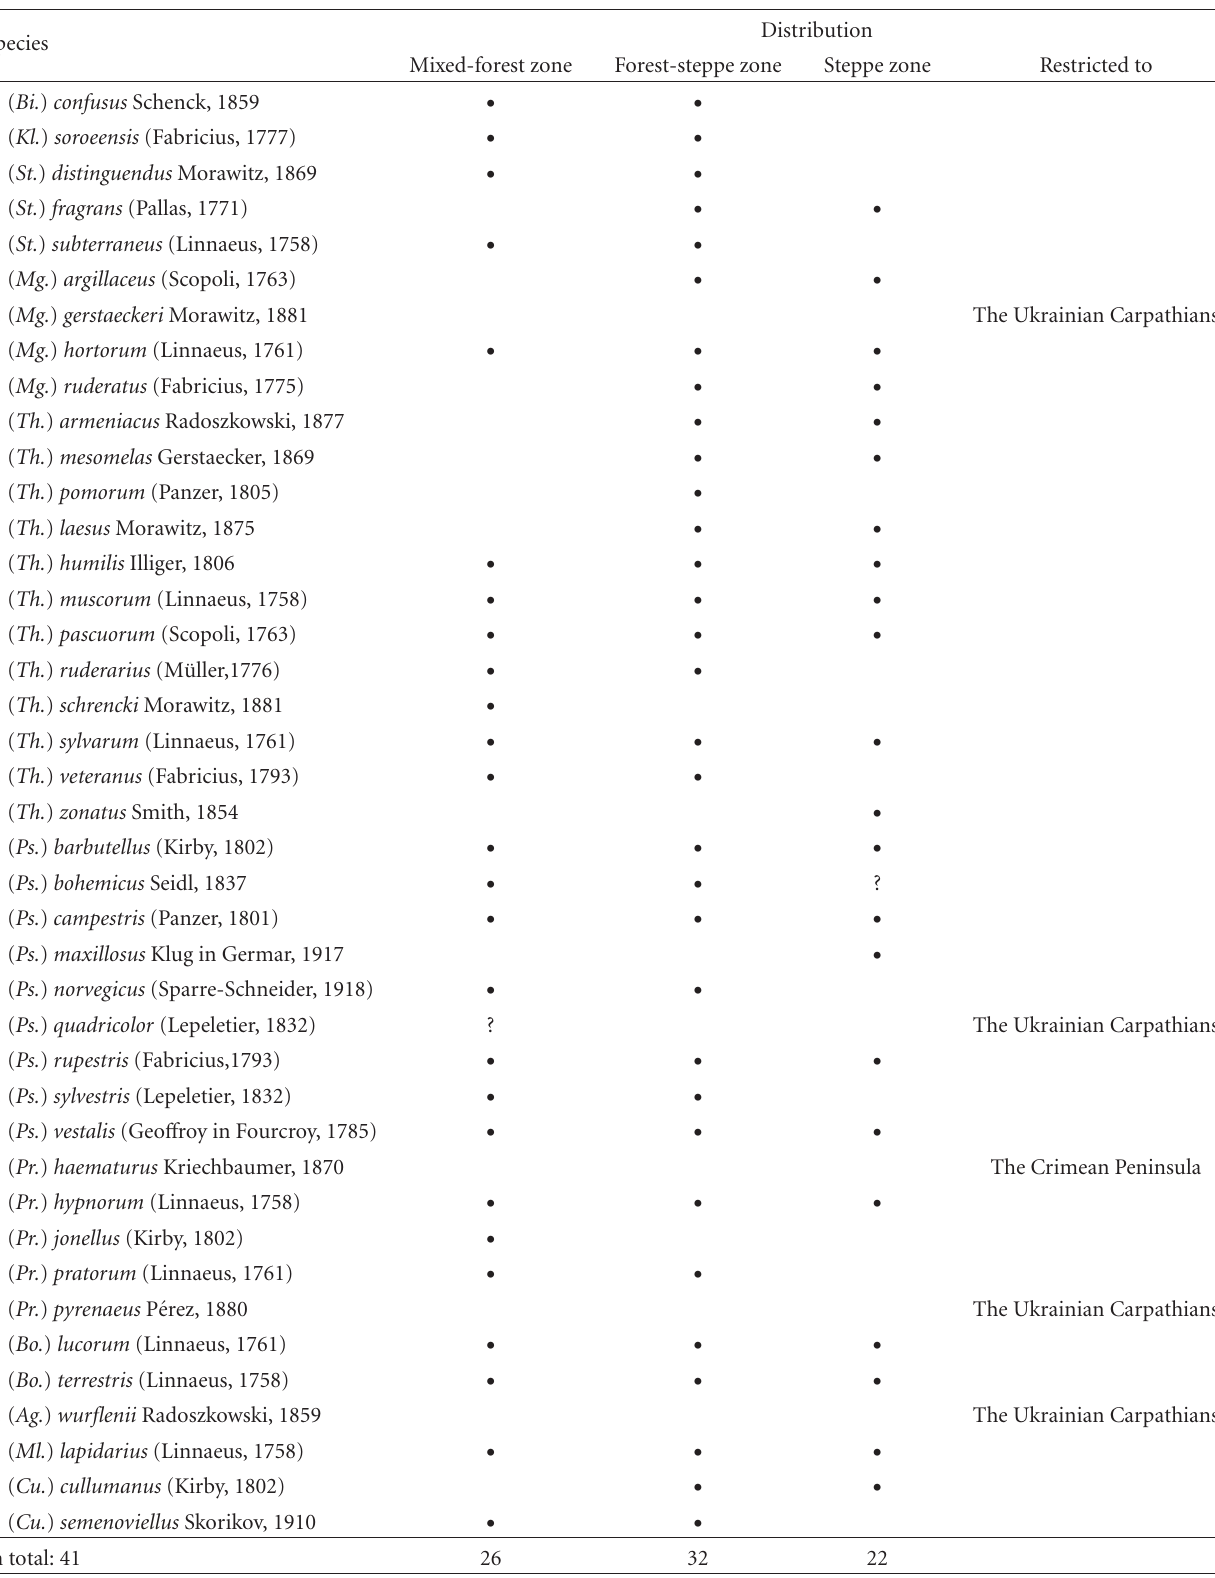
Table 1: Bumble bees of Ukraine and their distribution among geographical zones.